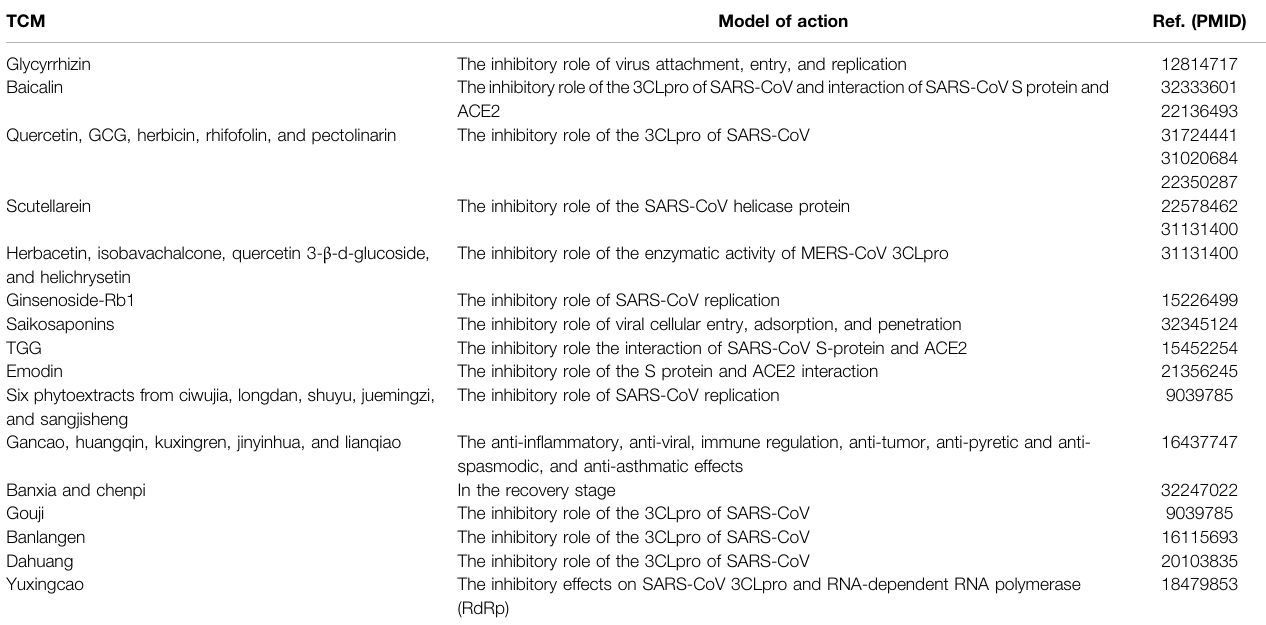
TABLE 1 | TCM herbal extracts or TCM-derived compounds with anti-HCoV activity.